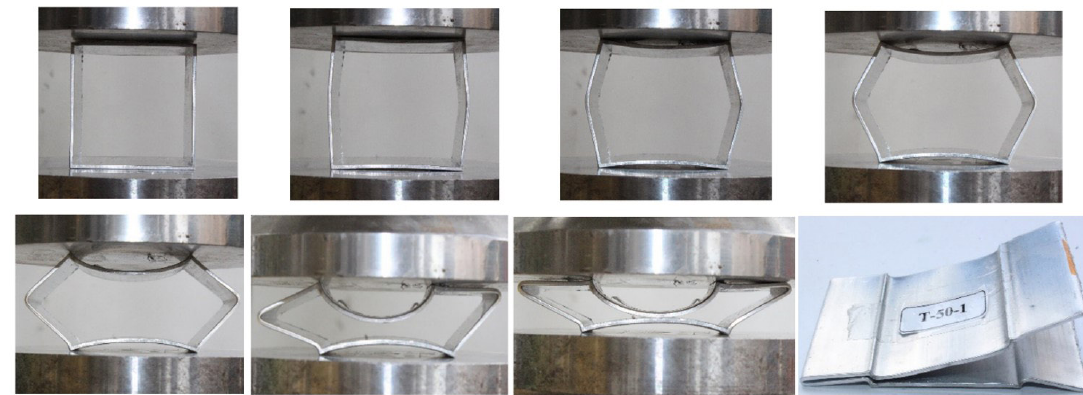
Figure 7. Stages of failure mode of hollow tube laterally crushed.